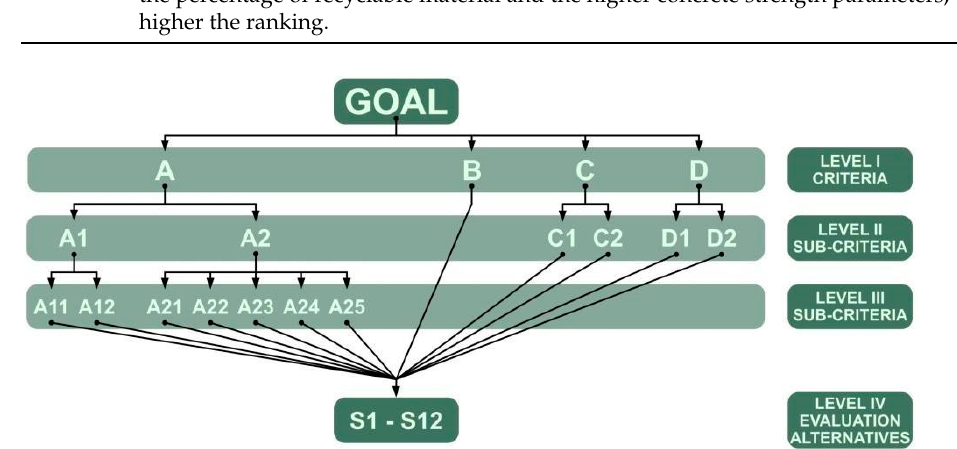
Figure 3. Graphical interpretation of the hierarchical control structure.